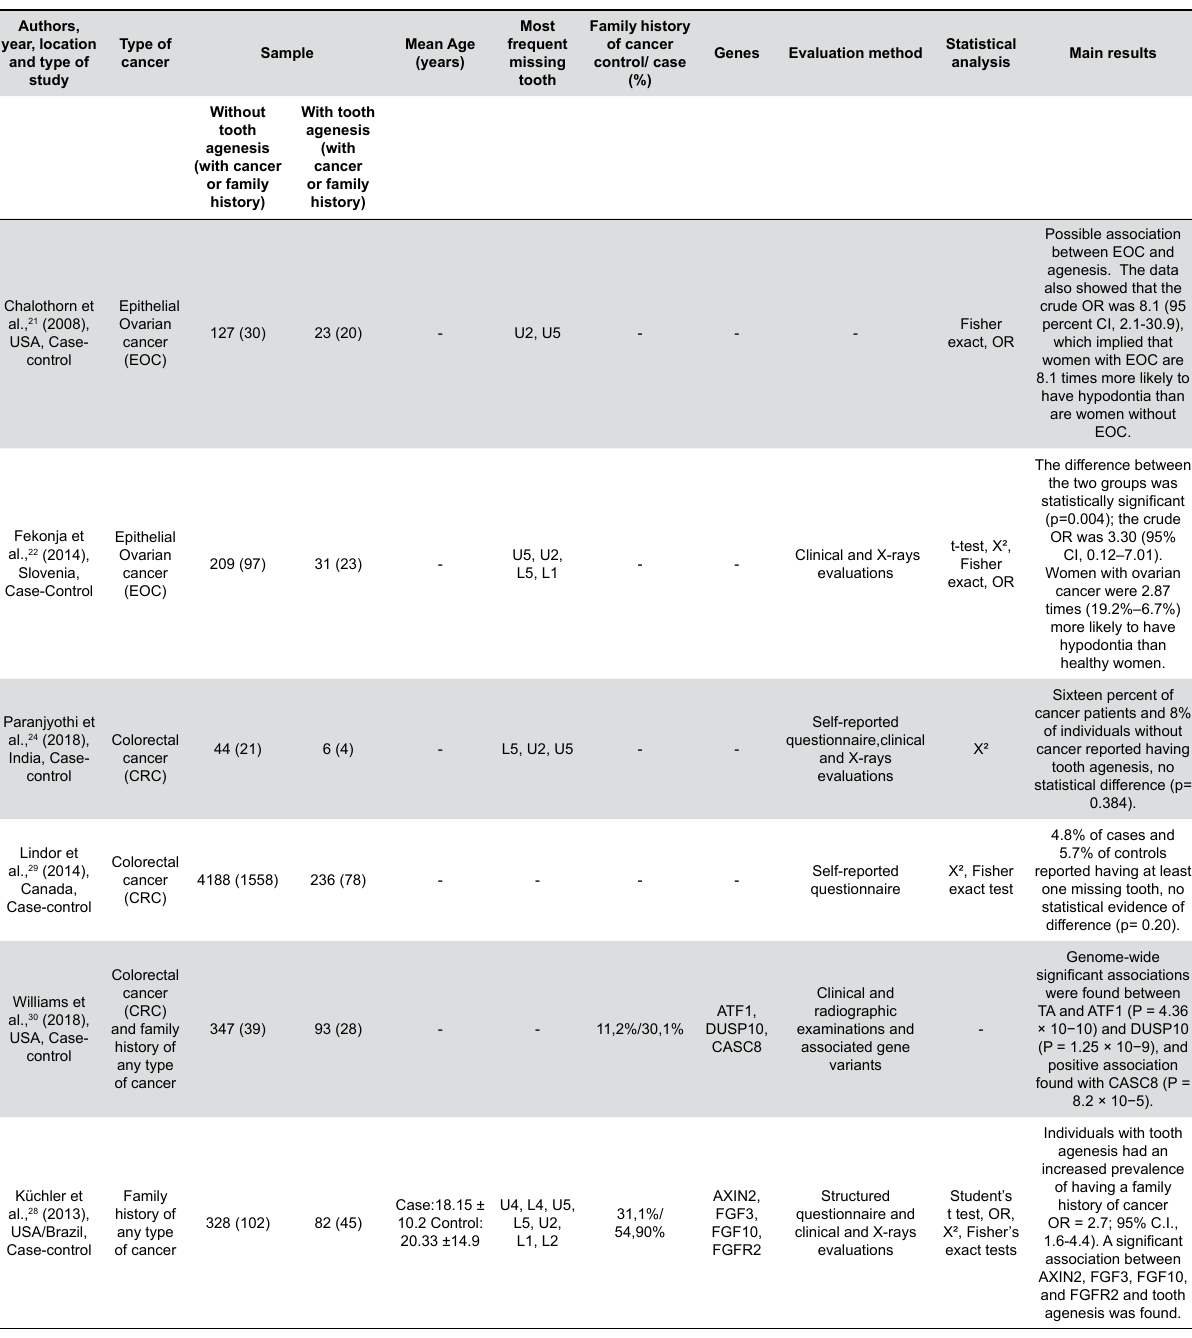
Table 1- Summary of the data from the studies included in this